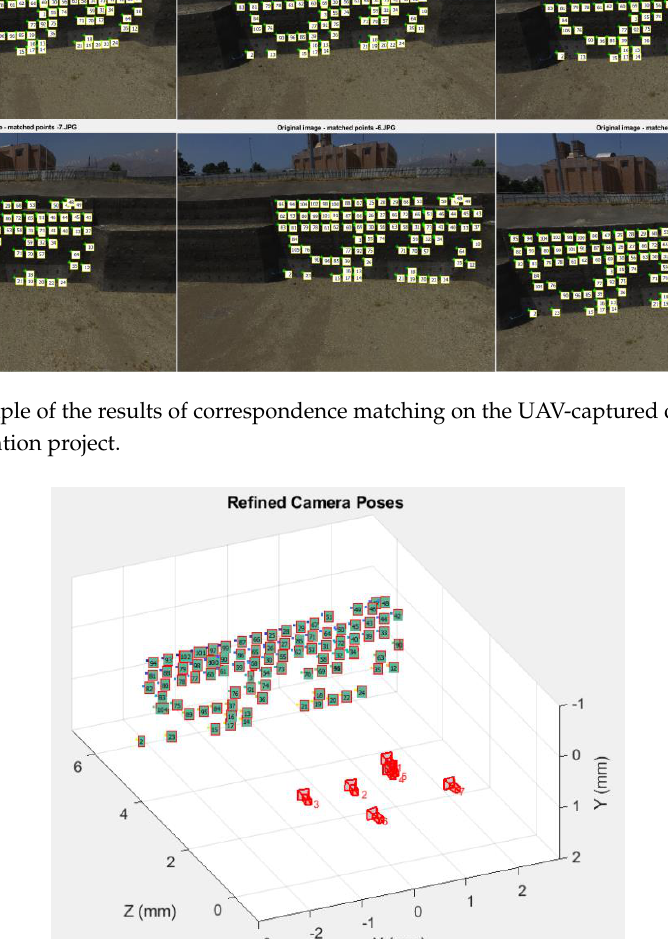
Figure 16. Generated three-dimensional coordinates of the points and some of the cameras (not in real scale).